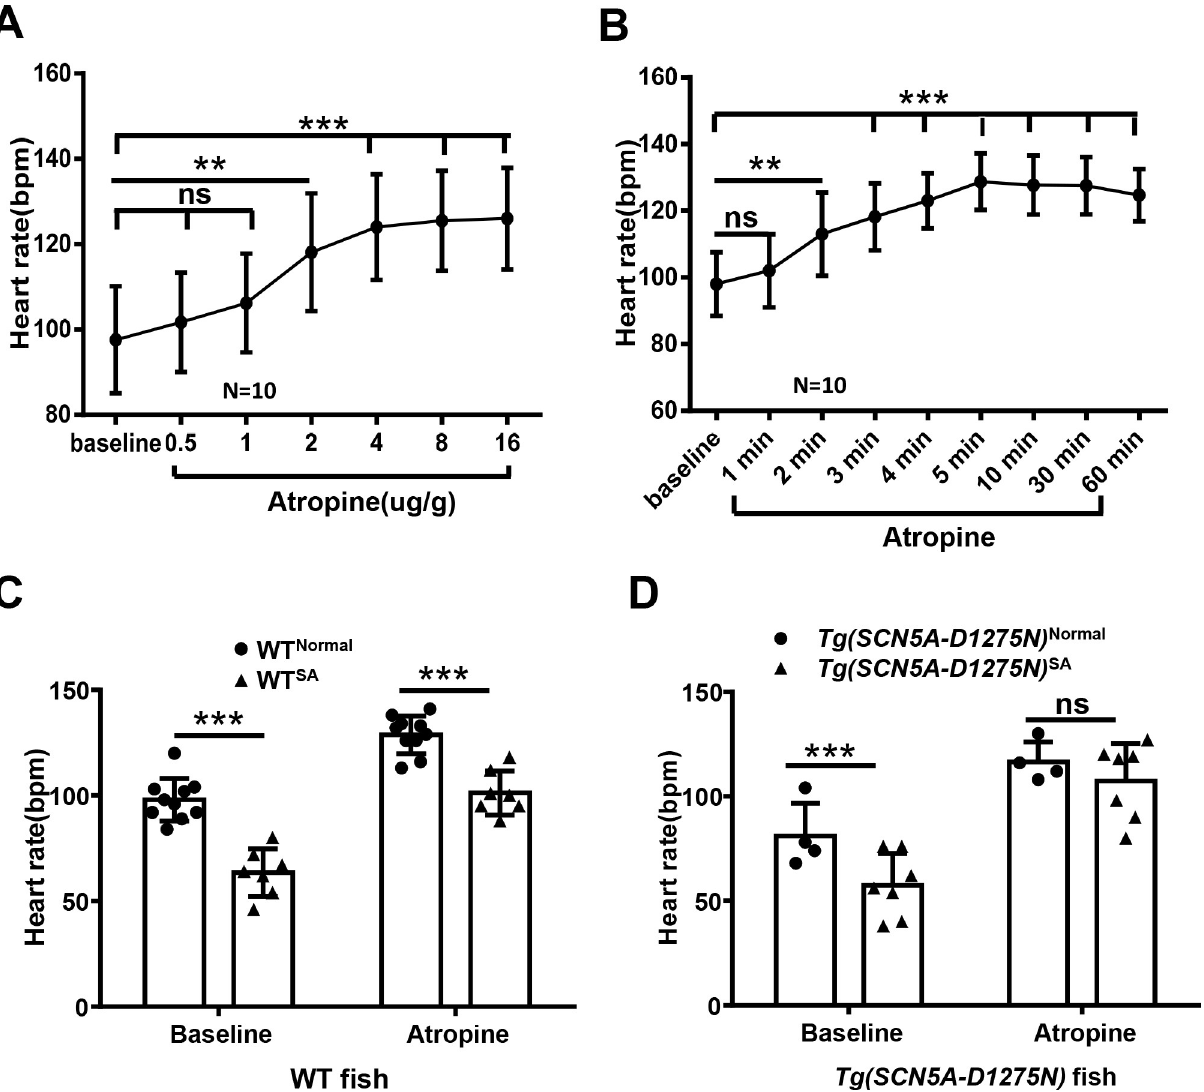
Fig 7. Chronotropic incompetence in subpopulation of Wild-Type (WT) fish with Sinus Arrest (SA) but not Tg(SCN5A-D1275N) fish. A, Quantification of heart rate in response to different concentrations of atropine (one-way analysis of variance). B, Heart rate response to atropine (4 μ g/g) over time (one-way analysis of variance). C, Quantification of heart rate increases in response to atropine (4 μ g/g) in WT fish. Heart rate in WT SA subgroup did not reach maximum, as in WT Normal siblings. D, Quantification of heart rate increases in response to atropine (4 μ g/g) in Tg (SCN5A-D1275N) fish. Heart rate in fish with SA episodes reached maximal in their siblings. �� P < .01 and ��� P < .001 (non-parametric tests). ns indicates not significant. https://doi.org/10.1371/journal.pone.0232457.g007 subpopulation of WT fish has reduced P amplitude and increased QRS/P. Second, this sub- population of WT fish, but not the Tg(SCN5A-D1275N) model, had compromised HR responses to atropine. The data suggested that parasympathetic nerve control of the sinus node is damaged in aging-associated SSS, but not in the transgenic model. These phenotypic differences must reflect different molecular natures of these two SSS models. Similar to aged humans with SSS, fibrosis in the sinus node contributes to the pathogenesis [2, 8], which might explain the increased QRS/P ratio [43]. In contrast, SCN5A is more prominently expressed in the peri-node region, which results in SSS via a different mechanism [44].